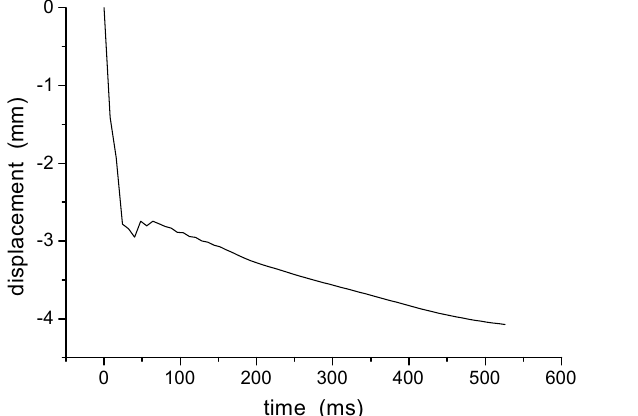
Fig. 3. The displacement-time history for the centre of the 3 mm plate indicating displacement converges after 520 ms of real time.